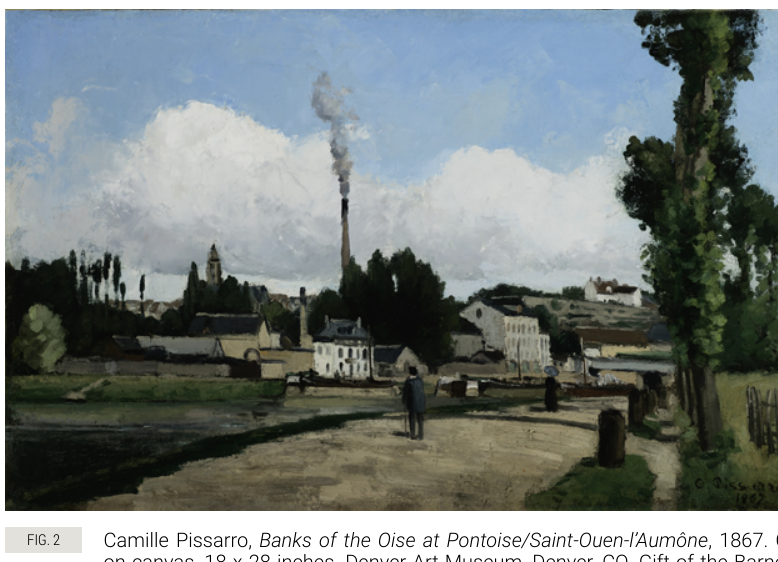
FIG. 2 Camille Pissarro, Banks of the Oise at Pontoise/Saint-Ouen-l’Aumône , 1867. Oil on canvas, 18 x 28 inches. Denver Art Museum, Denver, CO. Gift of the